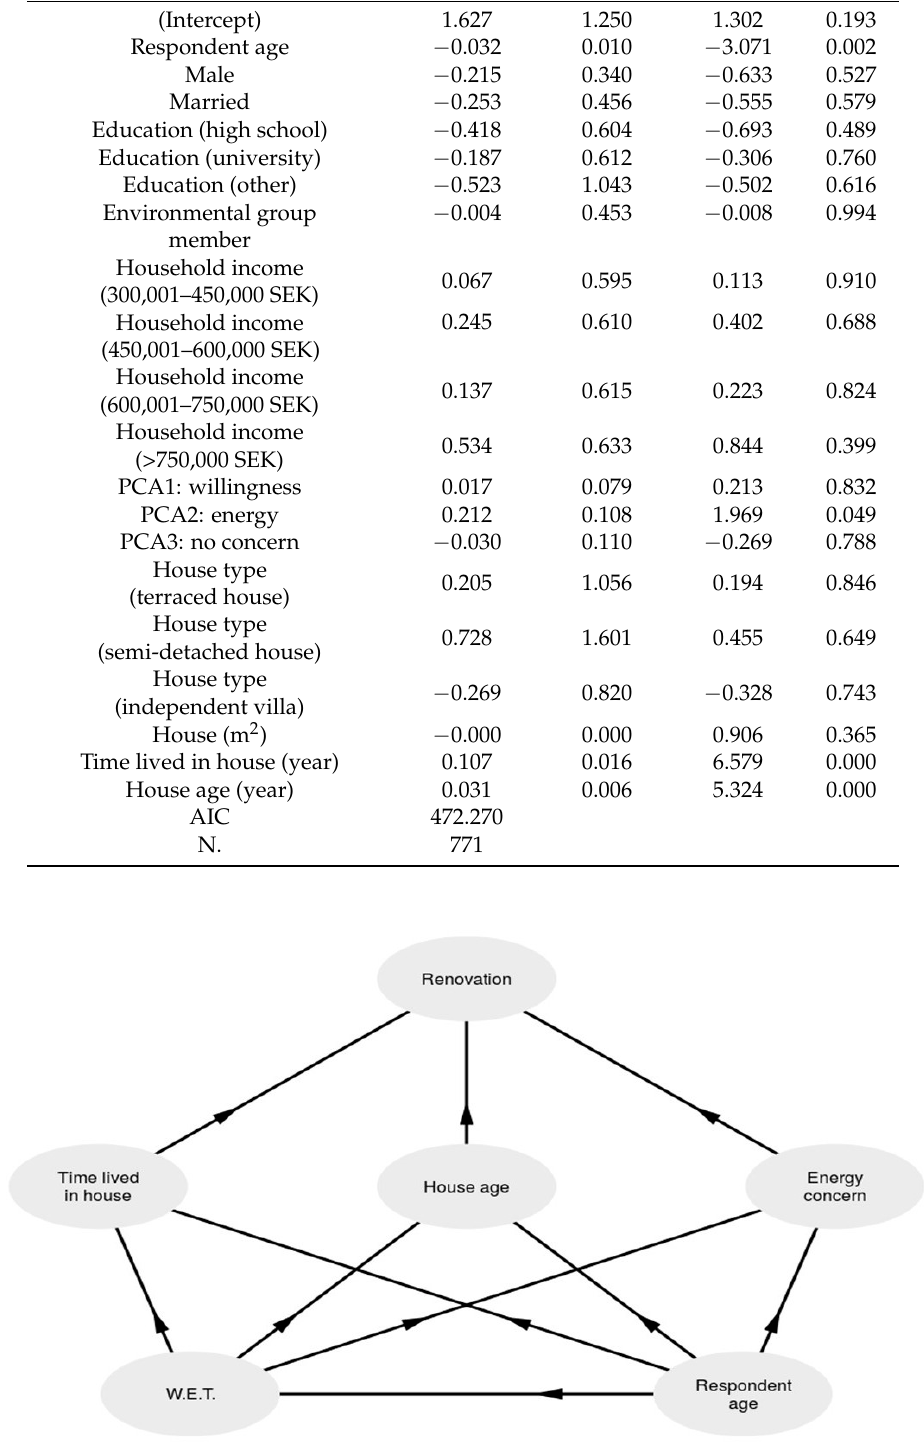
Figure 2. Structure of the renovation model.